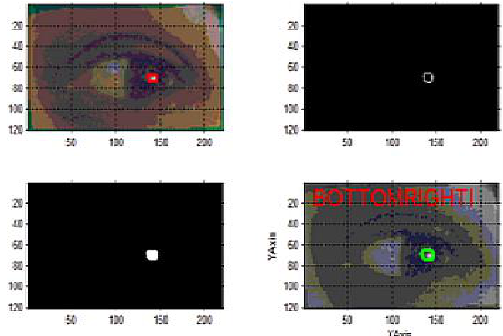
Figure 7: Superimposing I o on I i for mapping glint & gaze (a-d).